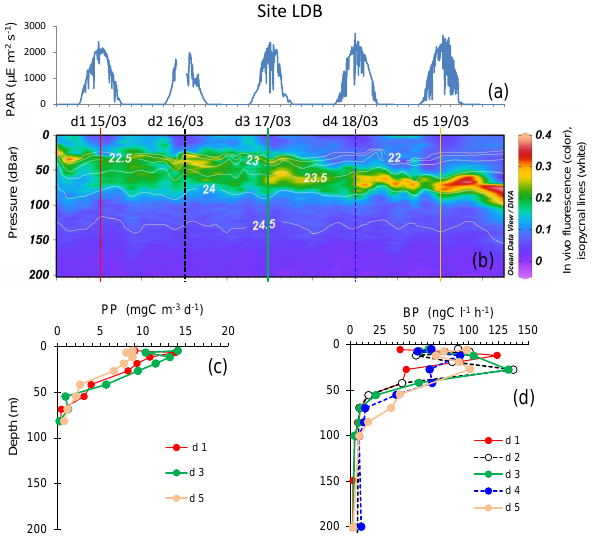
Figure 7. Evolution of surface PAR (a) , in vivo fluorescence and pycnoclines (b) , PP (c) and BP (d) at site LDC. Time units in local time; day 1 was 23 March 2015. BP samples were taken at the 12:00 ctd cast, while samples for PP insitu were taken at the 03:00 ctd casts (days 1, 3 and 5). In graph (b) in vivo fluorescence is in color, isopy- cnes (kgm − 3 ) are the white lines and vertical bars show the 12:00 ctd cast sampled for BP each day (1 to 5), with corresponding colors used for plotting BP vertical profiles in (d)